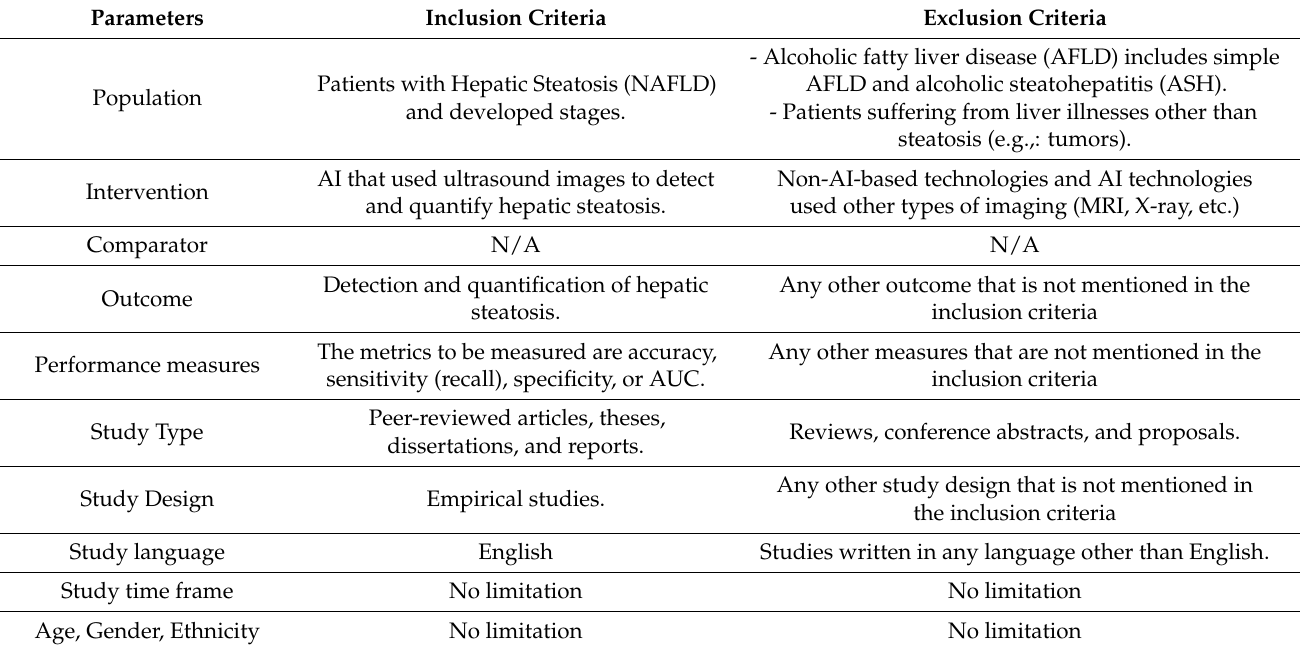
Table 1. Inclusion and Exclusion